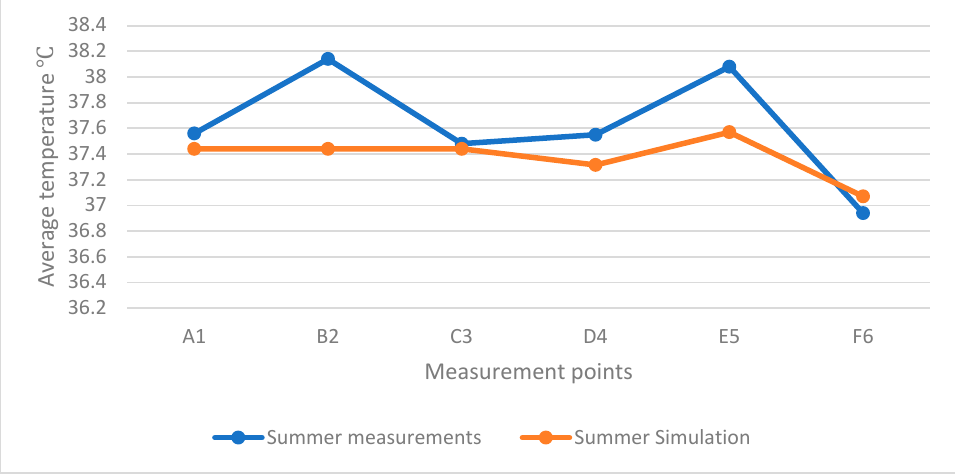
Figure 7. Comparison of the measured and simulated summer thermal environment in Zhuqiao village. Table 5. Measured and simulated MAPE values (%) in summer in Zhuqiao village.